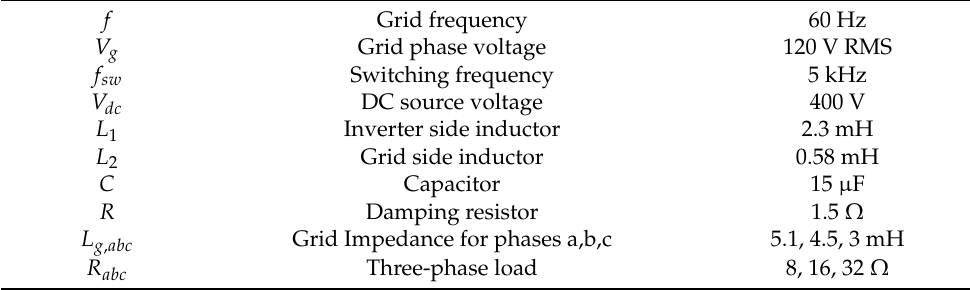
Table 1. Experimental System Parameters.